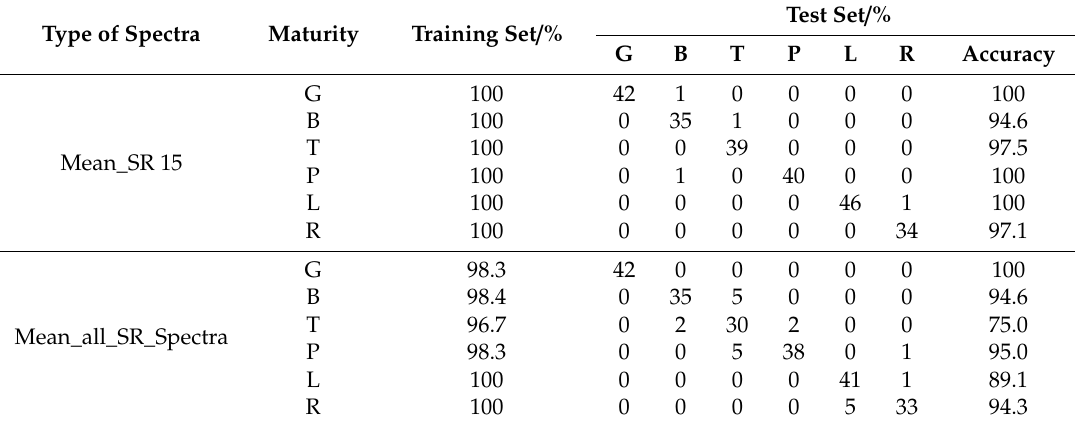
Table 3. Classification results for the six maturity of tomatoes by using Support Vector